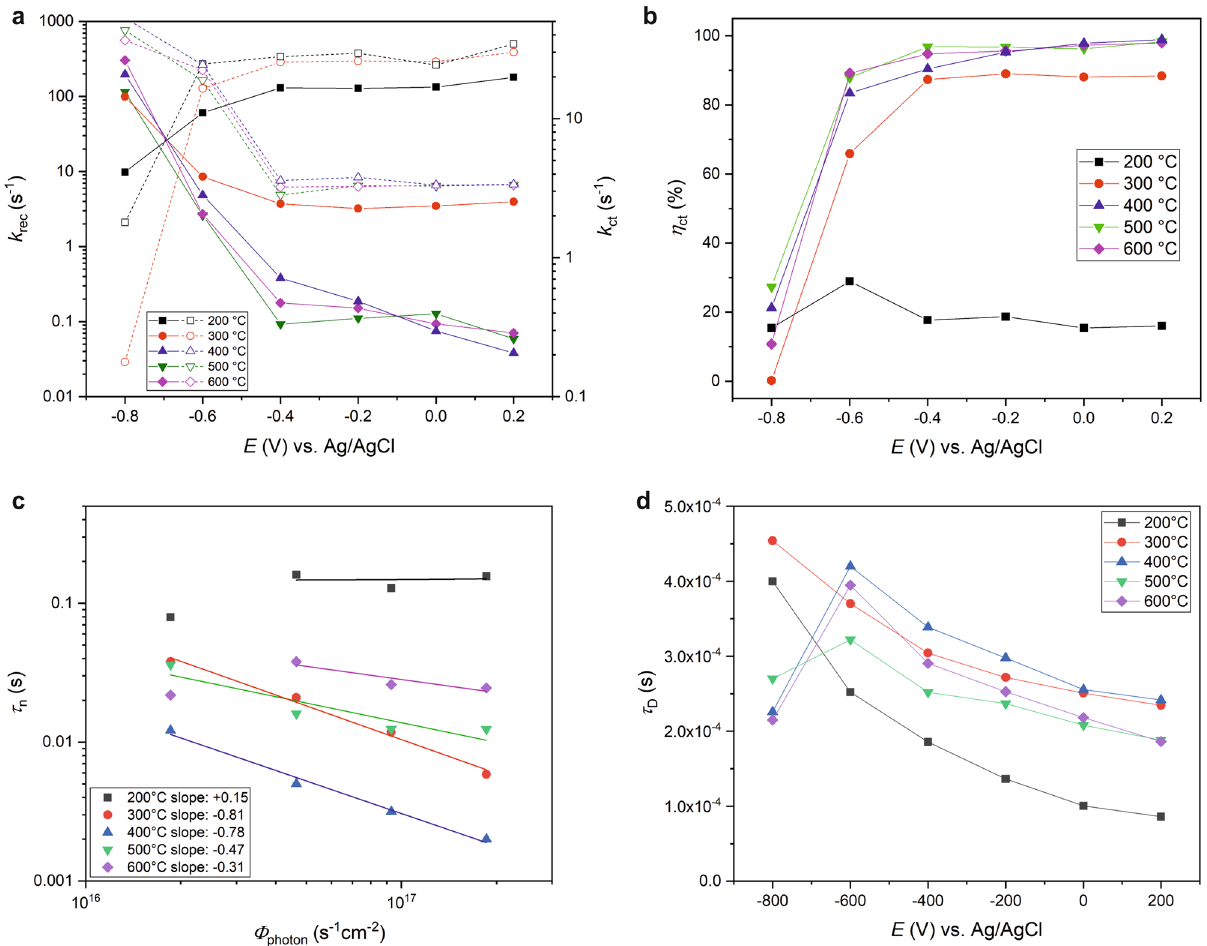
Figure 7. ( a , b ) Kinetic parameters as deduced from IMPS measurements with k rec being the surface hole recombination rate (a, filled symbols), k ct the surface hole charge transfer rate ( a , open symbols), and η ct the hole charge transfer efficiency ( b ) at different potentials. ( c ) Log-log plot of electron lifetime τ n versus incident photon flux (cid:31) photon as retrieved from IMVS measurements. Solid lines represent linear least-square regressions of each data set with the obtained slopes given in the legend. ( d ) Electron transit times τ D for each TiO 2 -coated FTO retrieved from IMPS measurements at different applied potentials and under 369 nm 100 W / m 2 irradiation. The drawn lines in ( a , b , d ) serve as guide to the